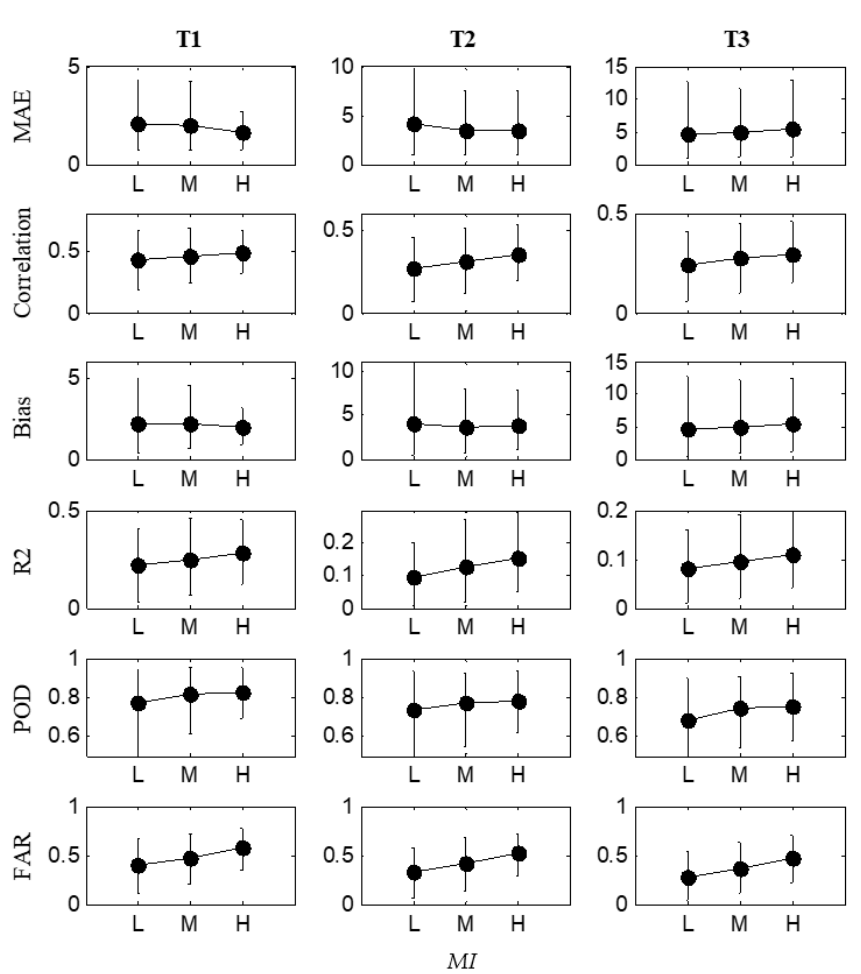
Figure 7. Relationship between rainfall nowcasting skill and rainfall temporal Moran’s I values.